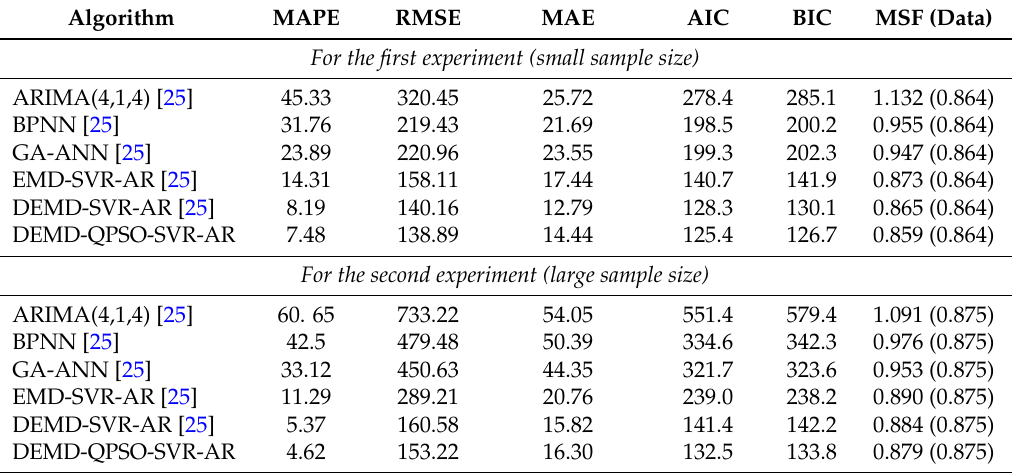
Table 8. Summary of results of the forecasting models in Case